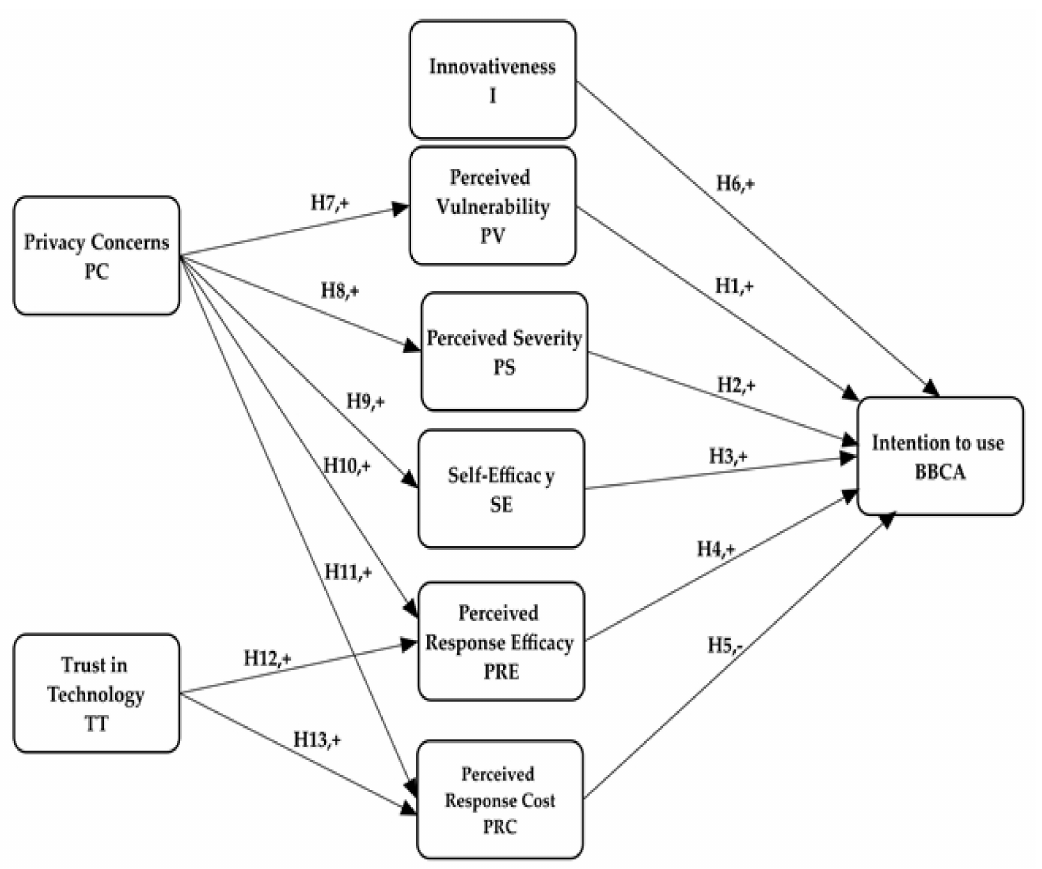
Figure 1. Research